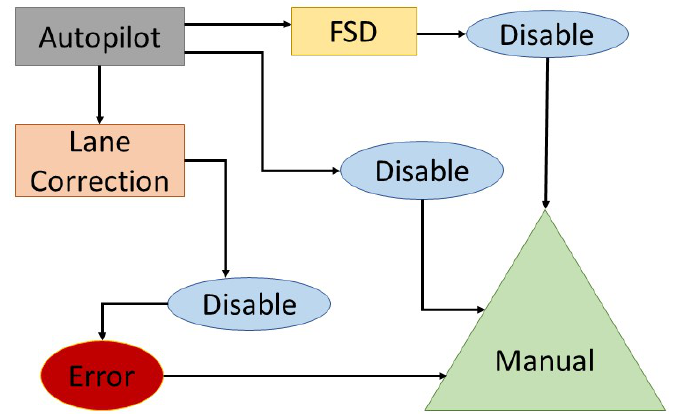
Figure 5. Schematic for Tesla Autopilot Suite, test driver’s